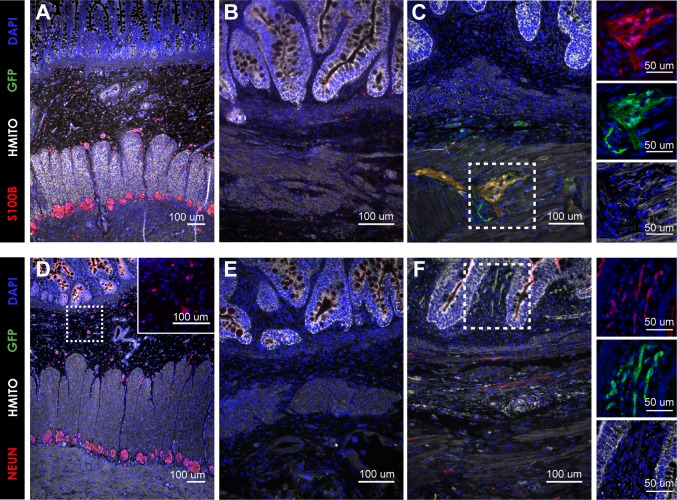
PGA scaffolds seeded with HIOs and GFP OU. The first group of PGA scaffolds were seeded with HIOs alone and the second were seeded with HIOs supplemented with OU derived from actinGFPmice. All constructs were implanted into the omentum of adult NOD/SCID mice and then harvested at 12 weeks. (A) Normal human small intestine contains glia (S100b) in the submucosal and myenteric plexi. (B) Staining tissue engineered intestine from HIO alone demonstrated no S100b+ glia. (C) Supplementation with murine GFP OU resulted in GFP+/hMito−/S100b+ glia predominantly in the myenteric plexus. (D) Normal human small intestine contains neurons (NeuN) in the submucosal and myenteric plexi. (E) Tissue engineered intestine derived from HIO alone demonstrated no NeuN+ structures. (F) Supplementation with GFP OU resulted in GFP+/hMito−/NeuN+ neurons predominantly in the submucosal layer. Scale bars: 100 μm; 50 μm in C and F, insets.